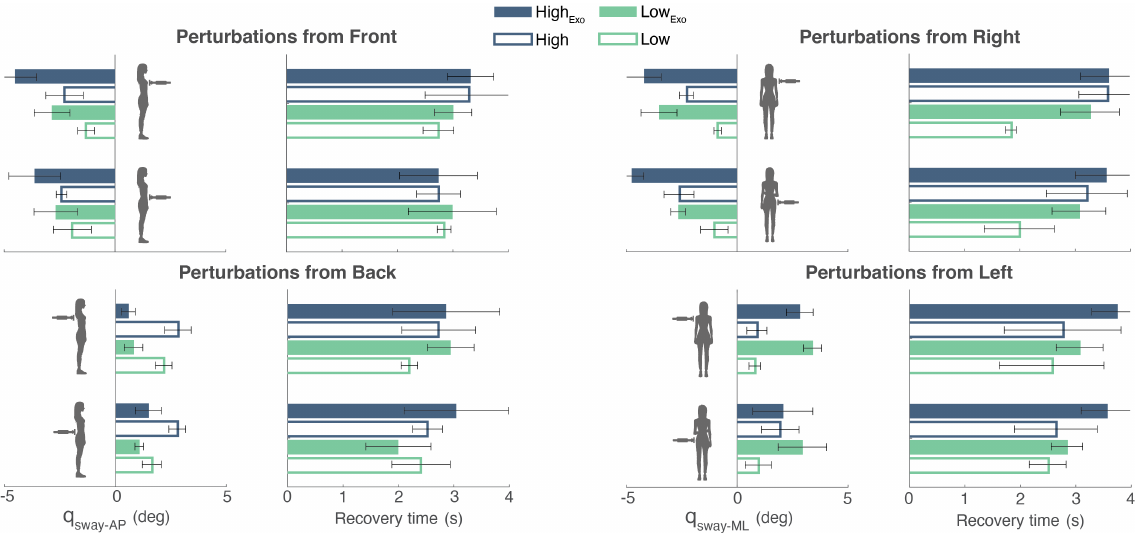
Figure 10. BIs calculation (mean ± SD) for all conditions of the protocol in both scenarios (exoskeleton present—filled bars; and exoskeleton not present—empty bars). Low and High magnitudes of perturbations are presented in green and blue, respectively. Note that for frontal and right-side perturbations, the q sway is negative, as it was established in the sign convention of Figure